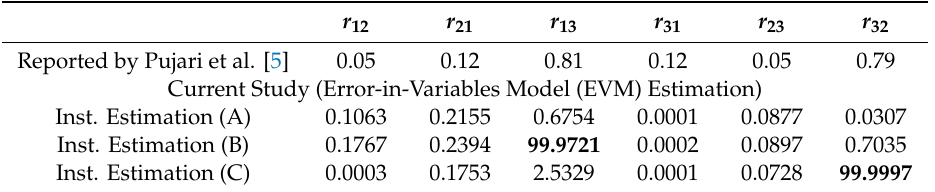
Reactivity ratio estimates for the terpolymerization of 4-hydroxystyrene (HOST) / 2-ethyl-2-adamantyl methacrylate (EAMA) / photoacid generator (PAG). Data from [5].